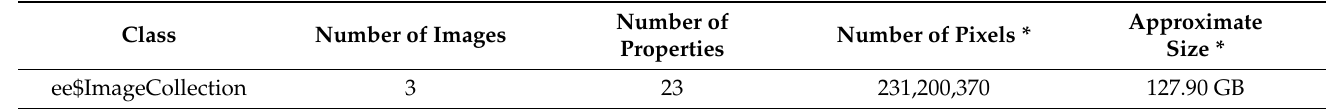
Table 6. Earth Engine COPERNICUS/S2_SR mosaic clipped on (01_Regenerative_Almonds)—